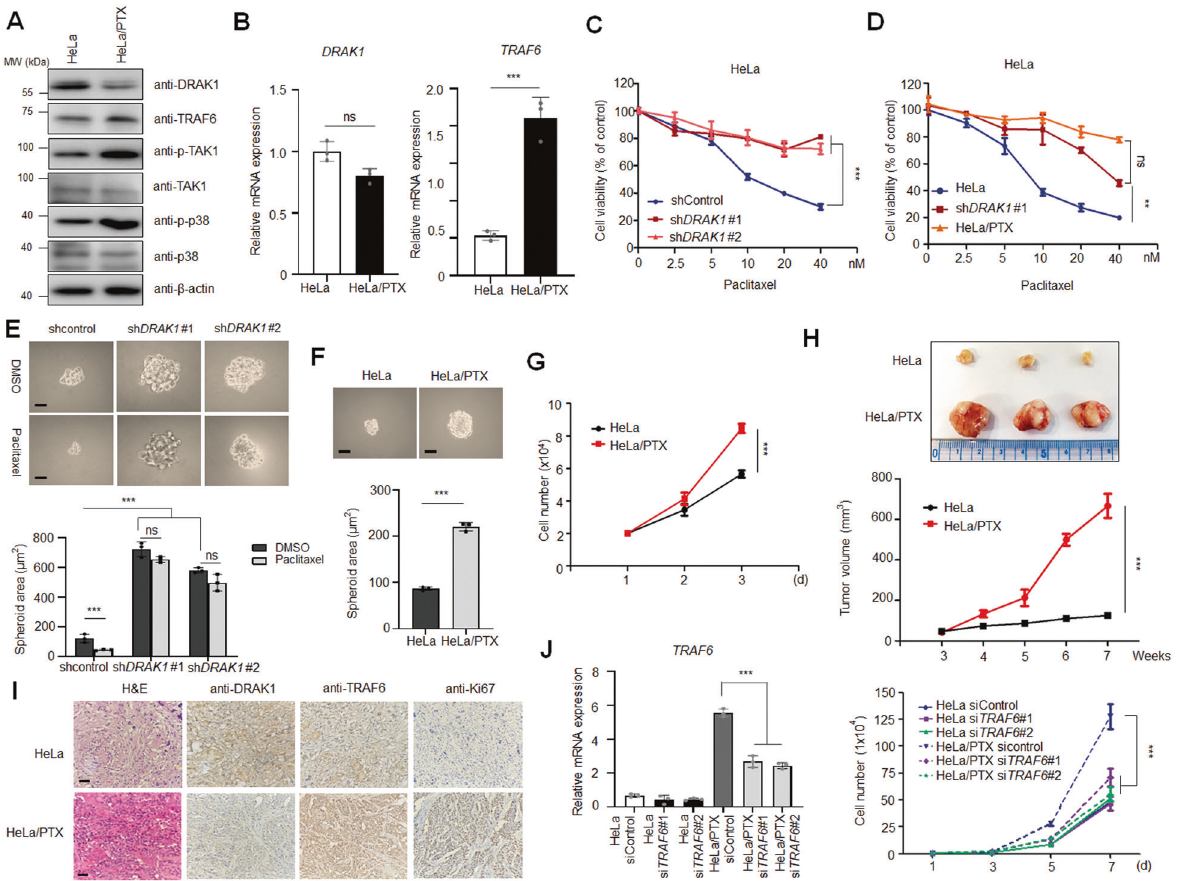
Fig. 1 Loss of DRAK1 protein is associated with paclitaxel resistance in cervical cancer cells. A Immunoblot analysis of parental HeLa and paclitaxel-resistant HeLa (HeLa/PTX) cells with indicated antibodies and β -actin was used for internal control. B qRT-PCR of DRAK1 and TRAF6 expressions in HeLa and HeLa/PTX cells and 18 s was used for internal control. The data represent the mean ± S.D. of three independent experiments. ns nonsigni fi cant * p < 0.05; ** p < 0.01; *** p < 0.001. C Cell viability assay of DRAK1 -knockdowned HeLa cells upon paclitaxel treatment ranging from 2.5 to 40 nM. The data represent the mean ± S.D. of three independent experiments. * p < 0.05; ** p < 0.01; *** p < 0.001. D Cell viability assay of DRAK1 -knockdowned HeLa cells and HeLa/PTX with parental HeLa cells upon paclitaxel treatment ranging from 2.5 to 40 nM. The data represent the mean ± S.D. of three independent experiments. ns nonsigni fi cant * p < 0.05; ** p < 0.01; *** p < 0.001. E Spheroid formation assay of DRAK1 -knockdowned HeLa cells upon paclitaxel treatment (10 nM). Original magni fi cation 100x. Scale bar, 20 μ m. The data represent the mean ± S.D. of three independent experiments. ns non-signi fi cant * p < 0.05; ** p < 0.01; *** p < 0.001. F Spheroid formation assay of HeLa and HeLa/PTX cells. Original magni fi cation 100x. Scale bar, 20 μ m. The data represent the mean ± S.D. of three independent experiments. * p < 0.05; ** p < 0.01; *** p < 0.001. G Cell doublings of HeLa and HeLa/PTX cells. The data represent the mean ± S.D. of three independent experiments. * p < 0.05; ** p < 0.01; *** p < 0.001. H In vivo tumor-formation assay of HeLa and HeLa/PTX cells subcutaneously injected into the fl anks of NRGA mice ( n = 8 per group). Primary tumor volumes were measured weakly starting 3 weeks after injection and mice were sacri fi ced at 8weeks. Representative primary tumor images (top) and tumor volumes (bottom) are shown. Error bars represent